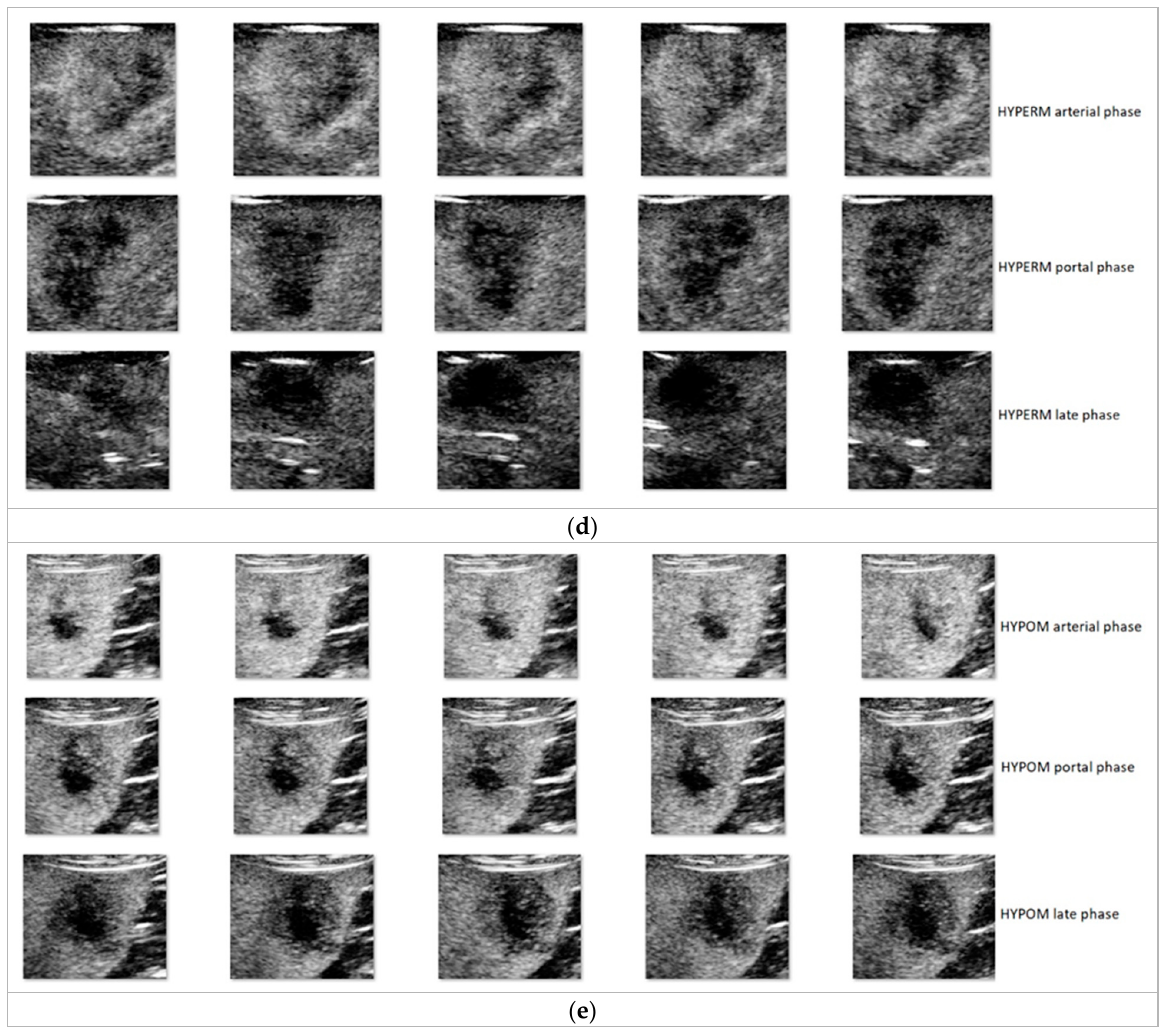
Figure 1. Five ROI representative examples, sampled at 10 frames difference, from each of the three (arterial, portal, late) CEUS exploration phases: ( a ) FNH; ( b ) HCC; ( c ) HMG; ( d ) HYPERM; ( e ) HYPOM.